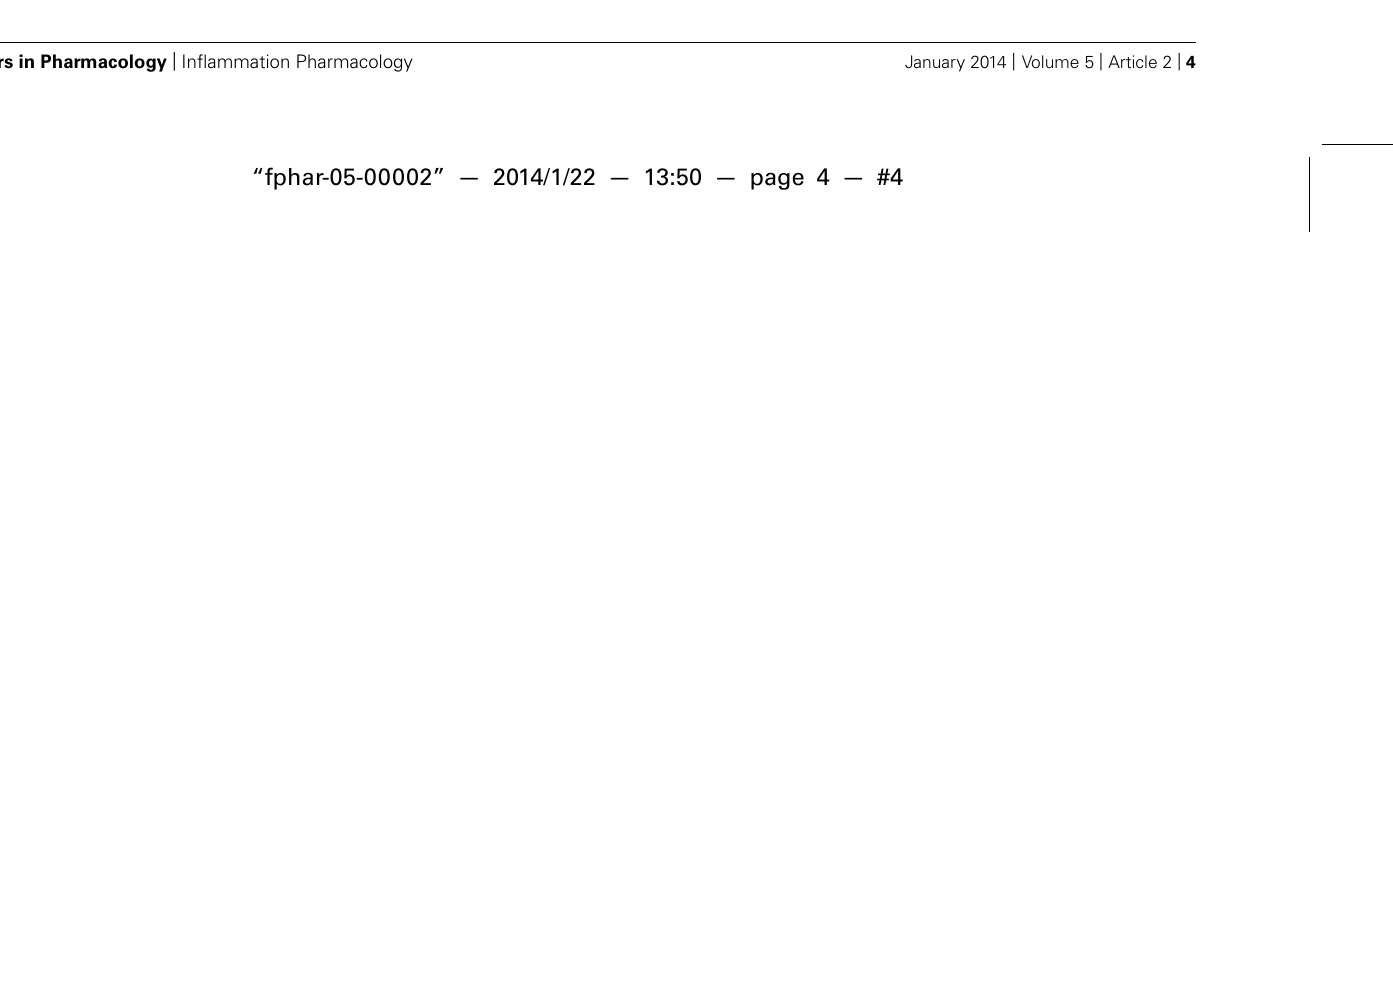
and the SHP2/ERK MAPK pathways (not shown). IL6 signaling is regulated via the action of several proteins and mechanisms including PIAS, SOCS, SHP2, and the shedding of IL6R α